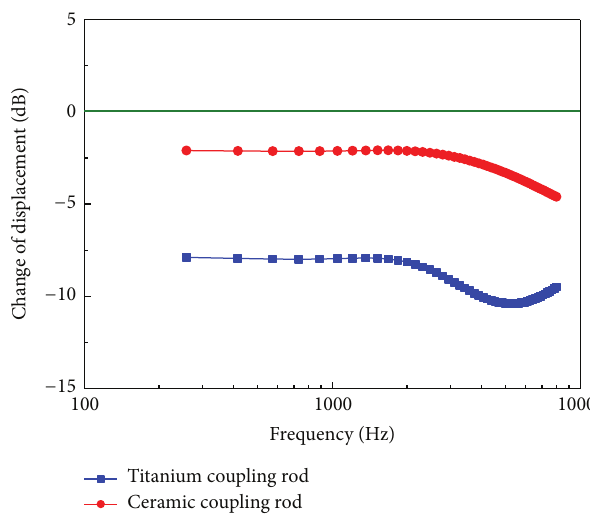
Figure 9: Change of transducer excited stapes displacement with the change of the coupling rod’s material.